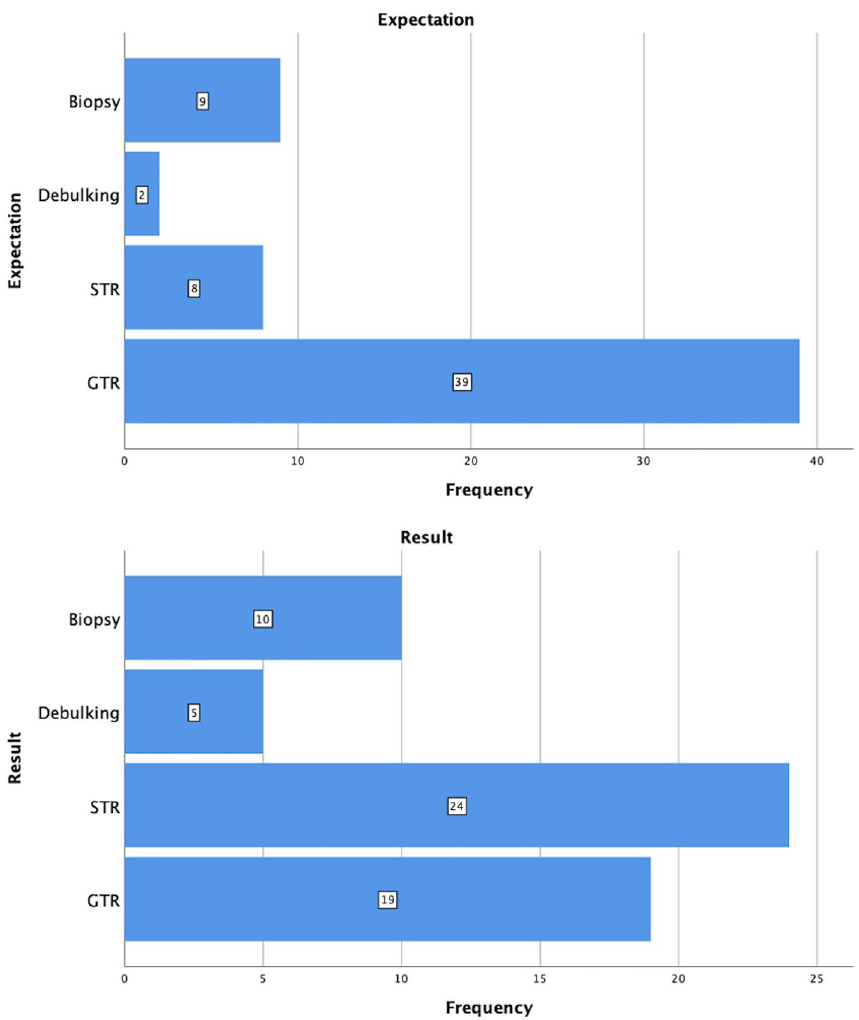
Figure 2. Expectations vs. results in transnasal endoscopic resection of clival